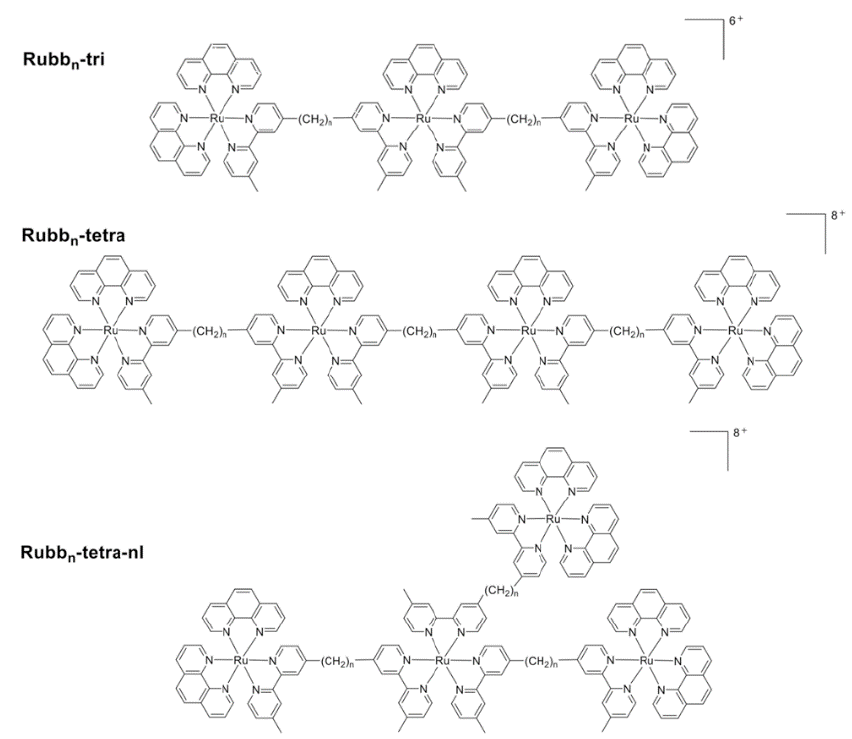
Figure 5. Chemical structures of the trinuclear polypyridyl ruthenium(II) complexes (Rubbn-tri), linear tetranuclear complexes (Rubbn-tetra) and nonlinear multinuclear ruthenium(II) complexes (Rubbn-tetra-nl)(reproduced from Reference [59]).